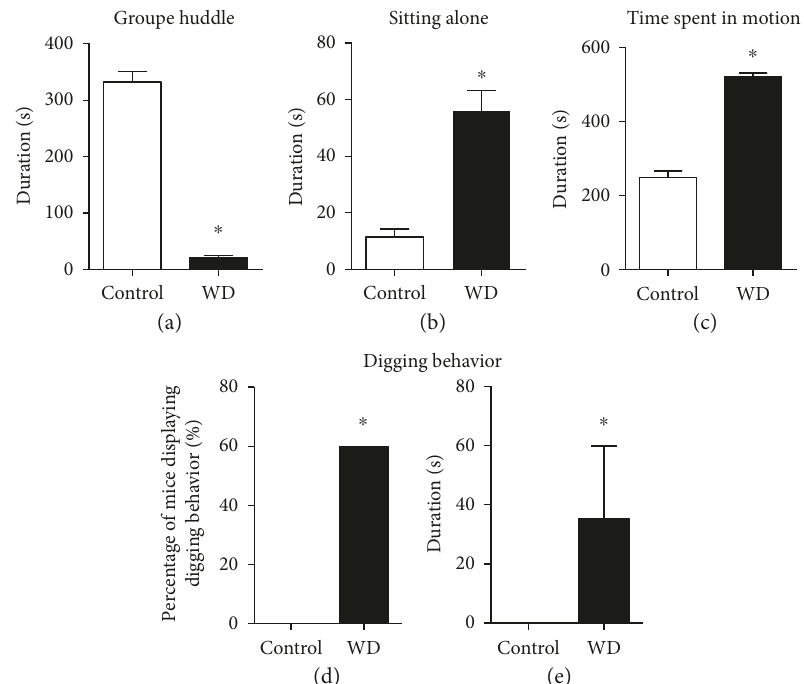
Figure 2: Dietary challenge with cholesterol results in aberrant home cage social behaviour. In comparison to control mice, the dietary- challenged group displayed (a) a signi fi cant decrease in the duration of group huddle, (b) a signi fi cant prolongation of the duration of “ sitting alone ” behaviour, and (c) a signi fi cant increase in the time spent in motion in the cage ( ∗ p < 0 05 versus that in the control group, t -test). As compared to control animals, a group fed with the cholesterol-enriched diet showed a signi fi cant elevation of (d) the percentage of mice displaying digging behaviour ( ∗ p < 0 05 versus that in the control group, Fisher ’ s exact test) and (e) the duration of digging behaviour ( ∗ p < 0 05 versus that in the control group, Mann-Whitney test). Control — standard diet, WD — high-cholesterol diet. Data are shown as mean ±